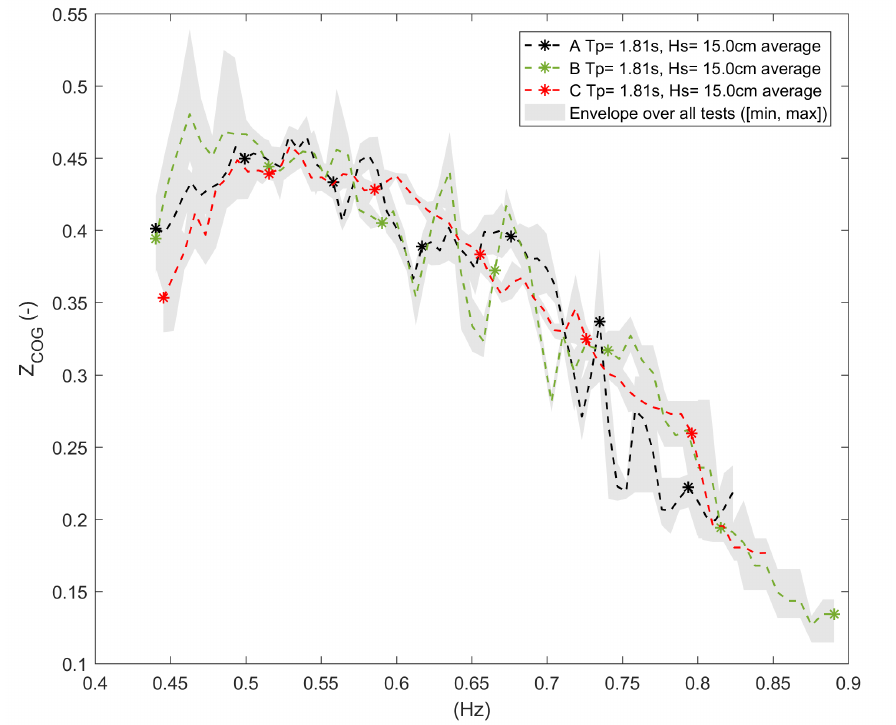
Figure 13. Heave RAOs for all JONSWAP T p = 1.81 s H s = 15 cm waves with distinct